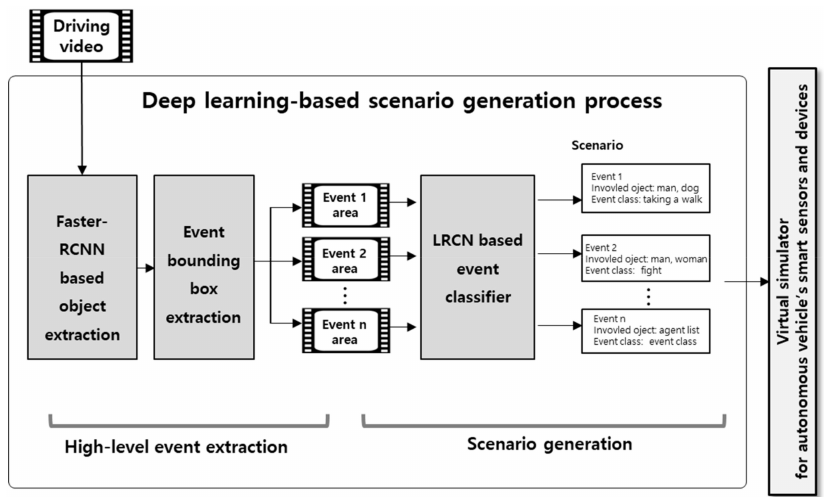
Figure 1. Proposed multi-event-based scenario generation approach.